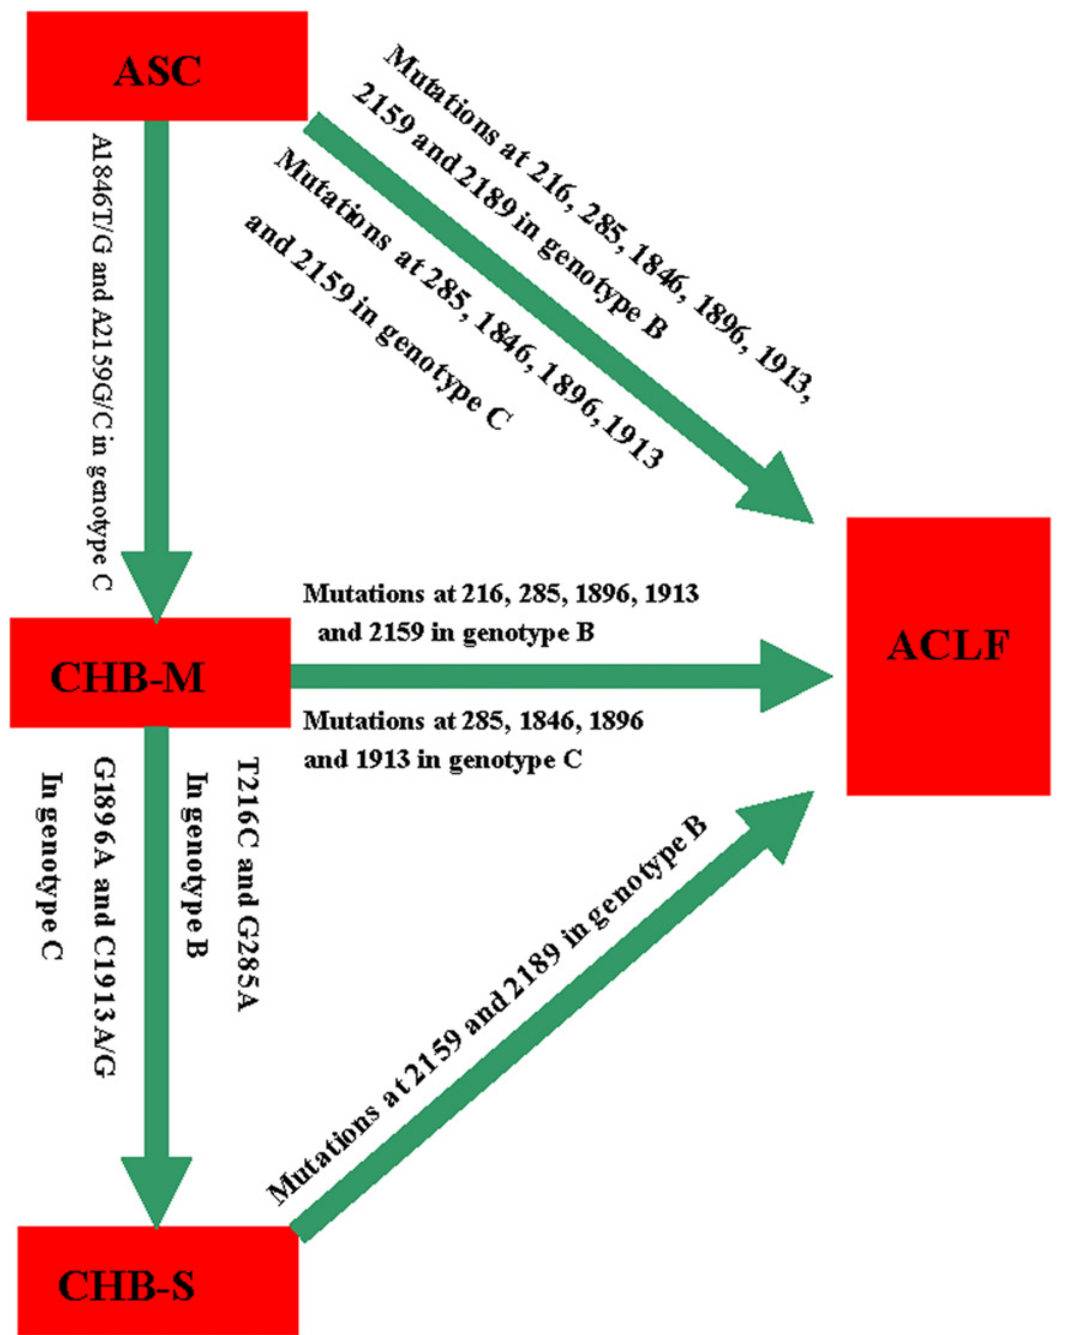
Fig 1. The associations of seven mutations in hepatitis B virus (HBV) with asymptomatic hepatitis B surface antigen carriers, mild chronic hepatitis B, severe chronic hepatitis B, acute on chronic liver failure in genotypes B and